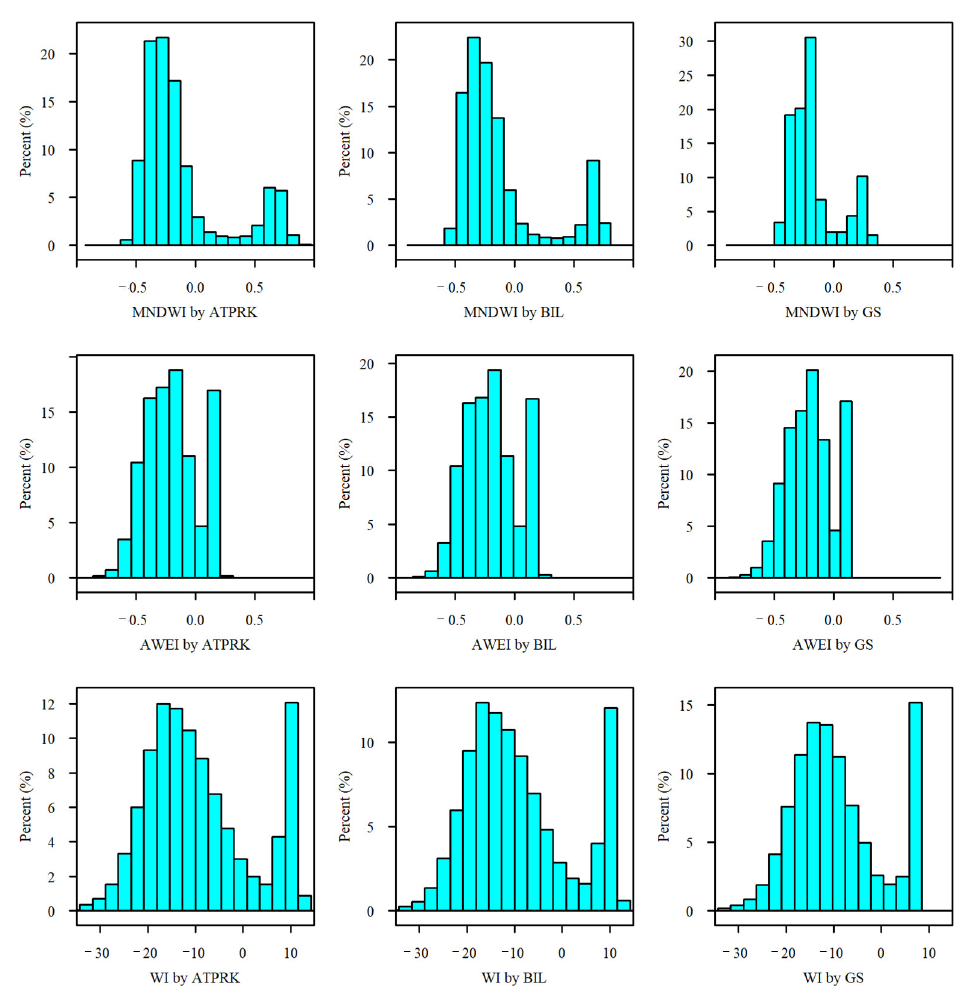
Figure 5. Histograms of the MNDWI, AWEI sh , and WI 2015 water indices using the ATPRK, BIL, and GS downscaling methods.